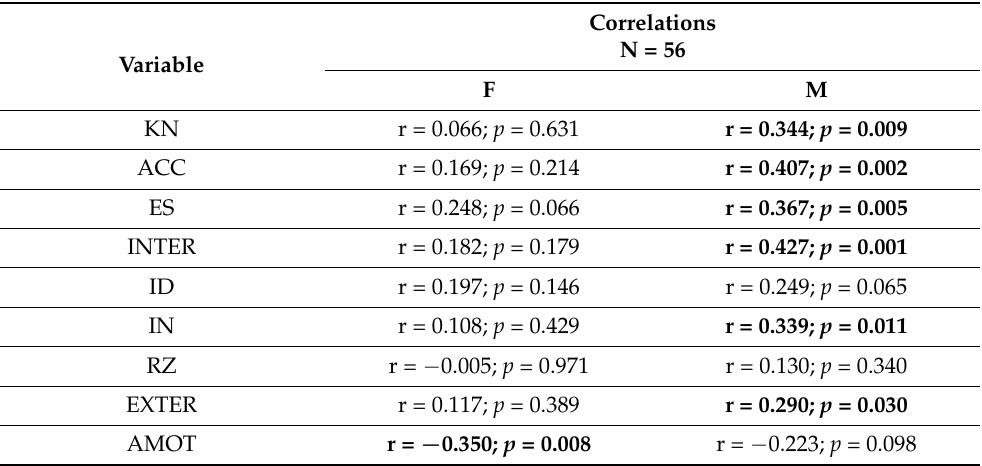
Table 2. Relationships between the levels of psychological femininity and masculinity and dimensions of motivation in a group of male respondents (players) training team sortie games—Pearson r correlation coefficients.